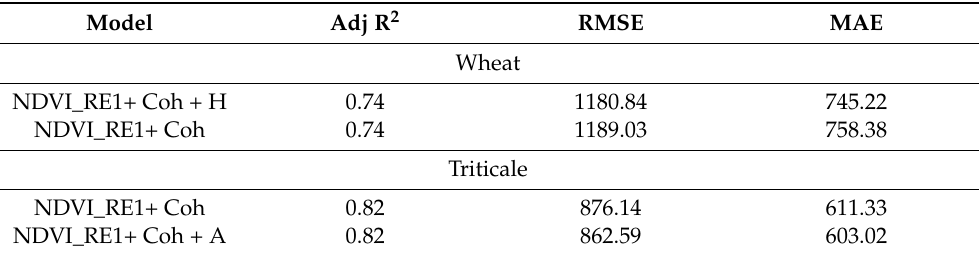
Table A3. Optical SAR results by species that removed 47 observations that experienced a termina- tion event between InSAR pairs. Results do not vary substantially from original model re-sults. No cereal rye models are presented because all termination dates occurred after In-SAR pairs. Species contrasts in